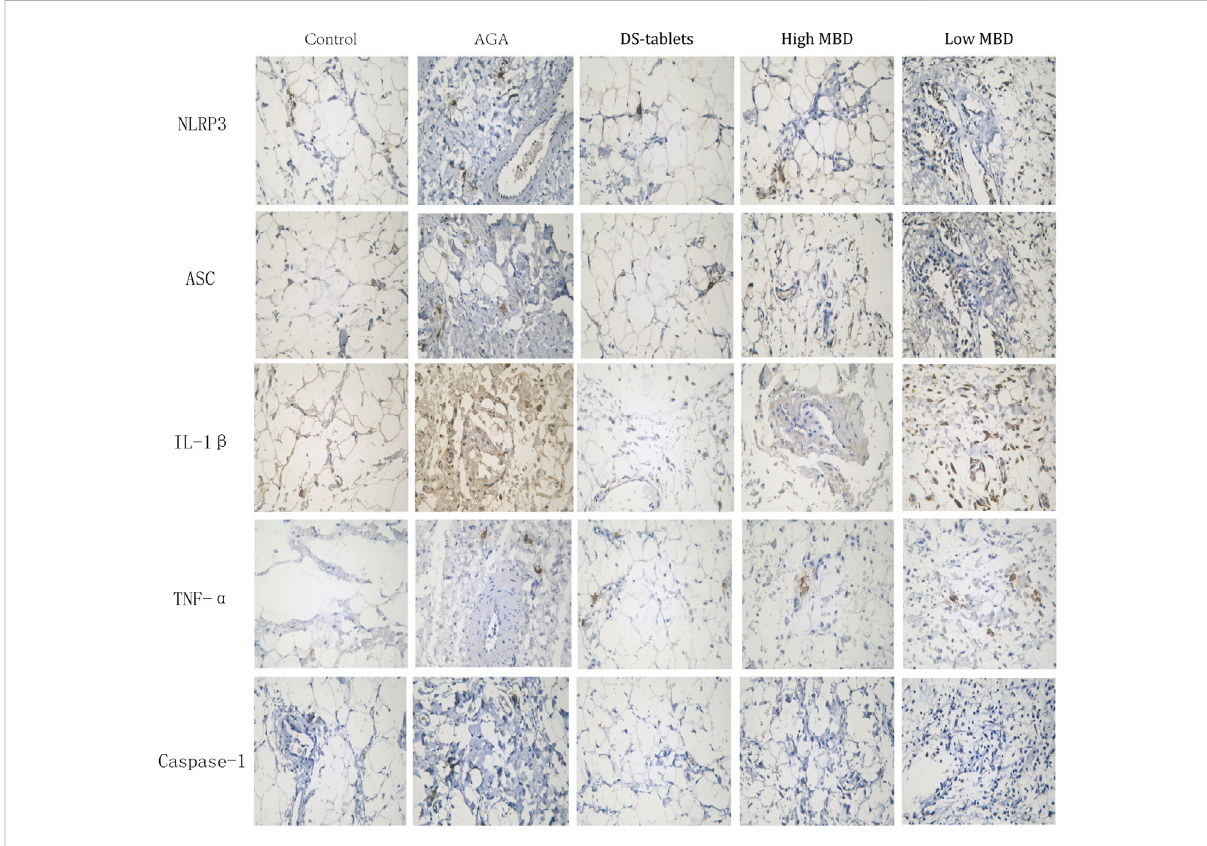
FIGURE 6 Expression of TNF- α , IL-1 β , NLRP3, ASC and Caspase-1 in synovial tissue. Positive phase contrast microscope, magni fi cation